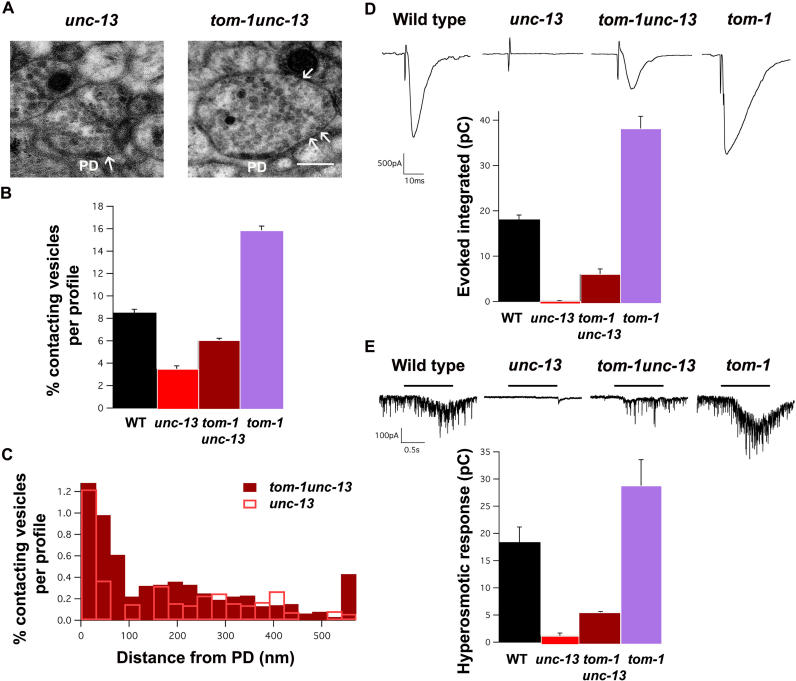
tom-1(ok285) Suppresses the Synaptic Defects of
unc-13(s69) Mutants
(A) Representative images of
unc-13(s69) and
tom-1(ok285)unc13(s69). (B) The ratio of plasma membrane-contacting vesicles per profile for WT (black),
unc-13(s69) (red),
tom-1(ok285)unc13(s69) (maroon), and
tom-1(ok285) (purple) scale bar = 200 nm
. (C) Comparison of
unc-13(s69) and
tom-1(ok285)unc-13(s69) plasma membrane-contacting vesicle distribution relative to the PD in 30-nm bins. (D) Representative NMJ recordings demonstrate that the evoked response absent in
unc-13(s69) mutants is partially restored in
tom-1(ok285)unc13(s69) double mutants. The average evoked charge integral of the
tom1 unc-13 double mutants is graphed relative to WT and
tom-1(ok285) mutant responses
. (E) Representative recordings of hyperosmotic responses demonstrate that the readily releasable pool of vesicles is increased in
tom-1(ok285) relative to WT. The hyperosmotic response absent in
unc-13(s69) mutants is also partially restored in
tom-1(ok285)unc13(s69) double mutants. The mean total charge integral for synaptic events in the first second of the hyperosmotic response is graphed. Data expressed as mean ± SEM.